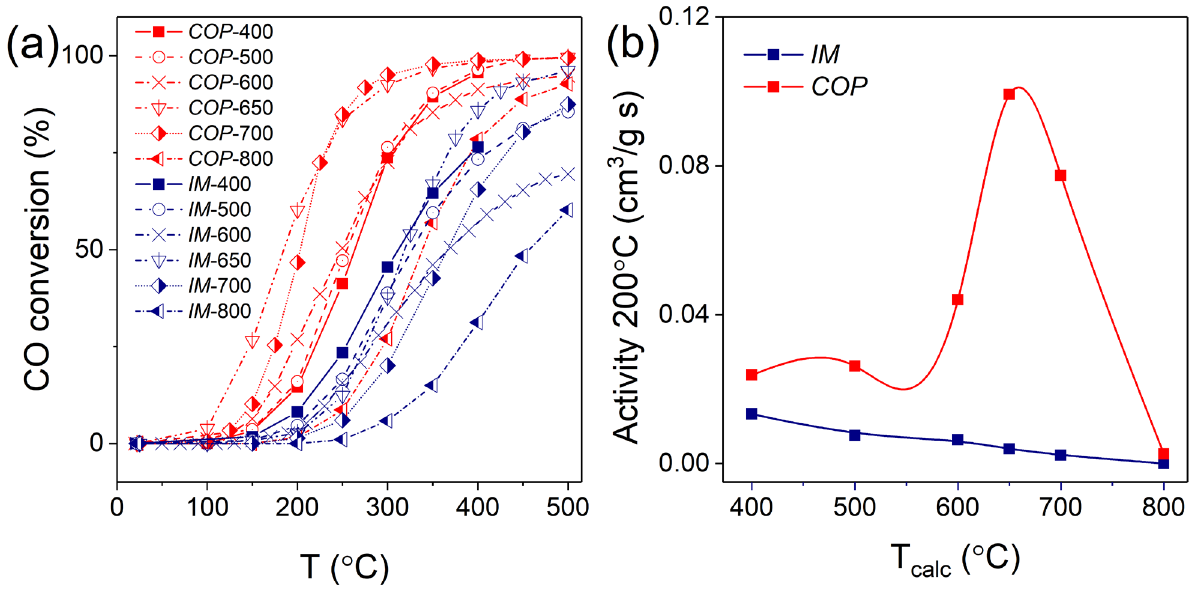
Figure 1. CO oxidation conversion ( a ) and rate at 200 ◦ C ( b ) depending on the preparation temperature for MnOx-ZrO 2 catalysts obtained by co-precipitation (COP) and impregnation (IM).